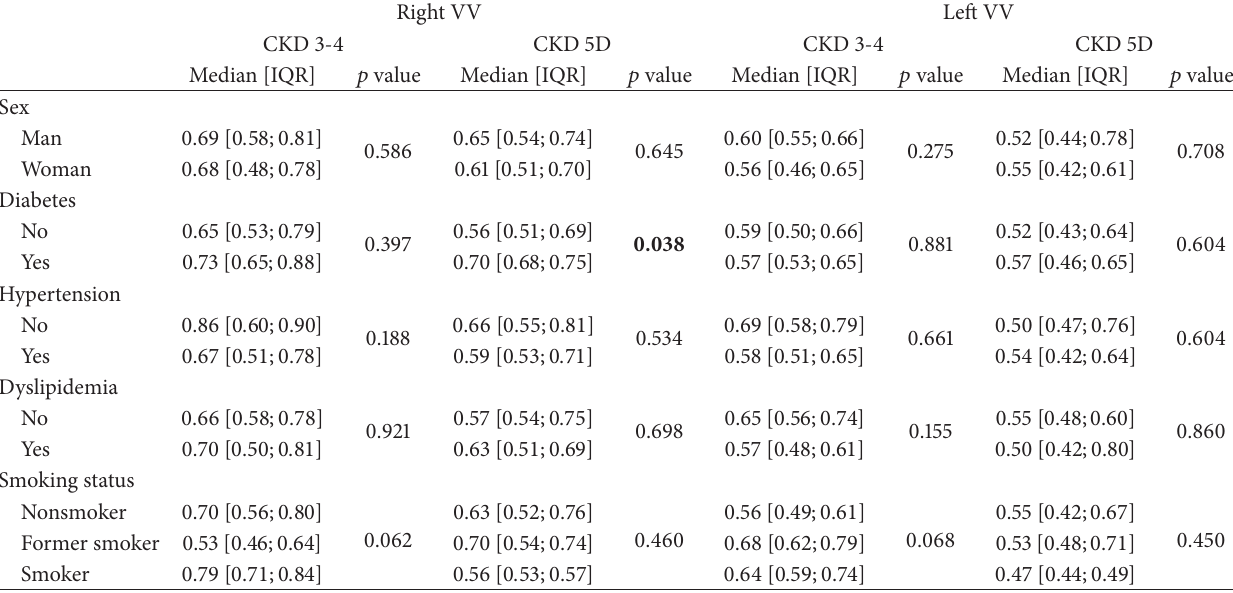
Table 4: Association between adventitial VV and clinical dichotomous variables in CKD